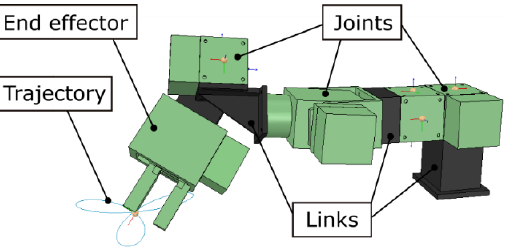
Figure 1. Example of a manipulator with links, joints, and an end-effector.